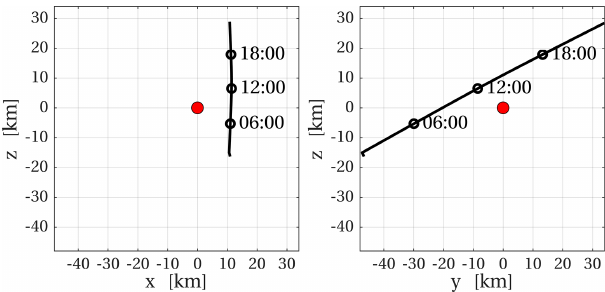
Figure 1. Trajectory followed by the Rosetta spacecraft during the close flyby on 28 March 2015. The red circle represents the nucleus of comet